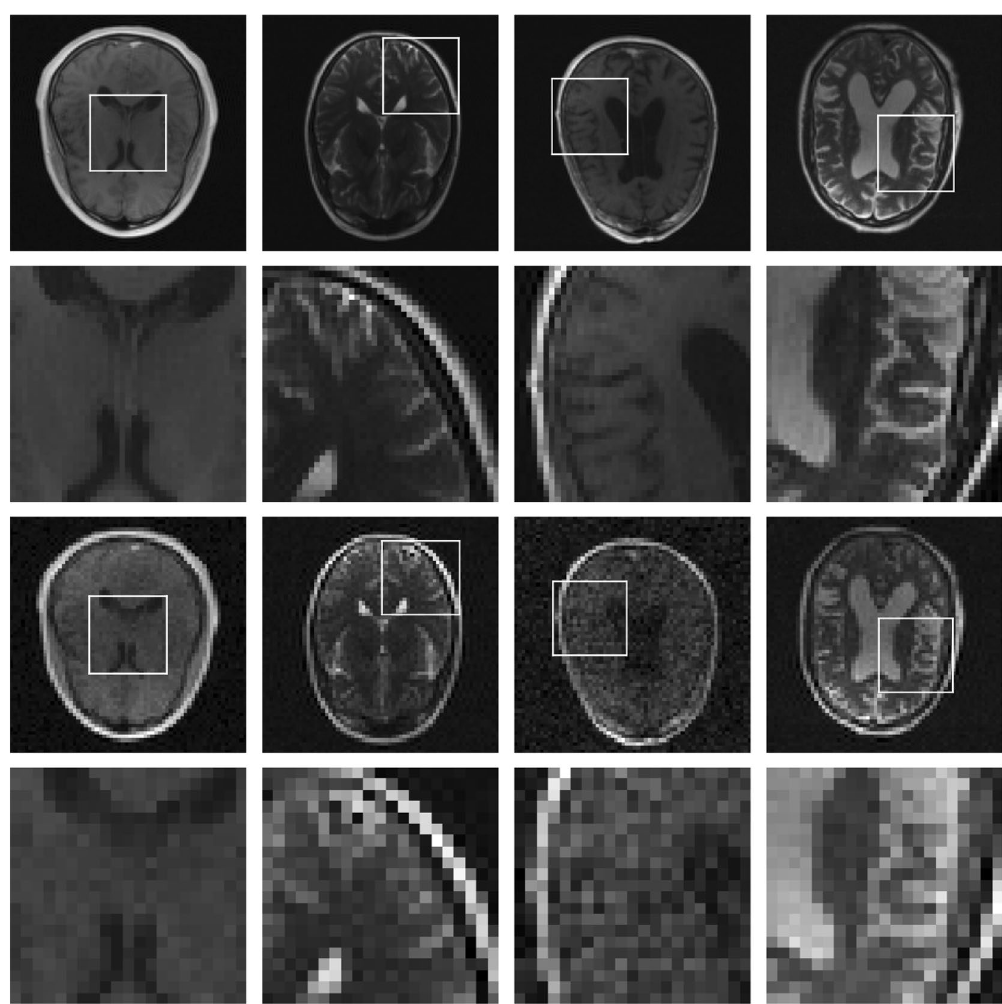
Figure 3. Examples of HR-LR image pairs in the training set. The first row contains four different HR images, with the white squares denoting patches whose zoomed-in versions are shown in the second row. In the third row, the corresponding (noisy) LR images are shown, with the fourth row containing LR versions of the patches in the second